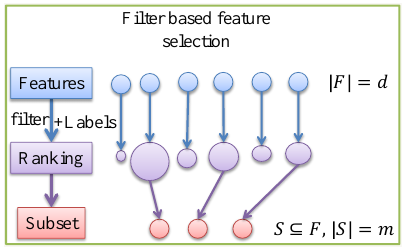
Figure 5. Diagram of filter based feature selection